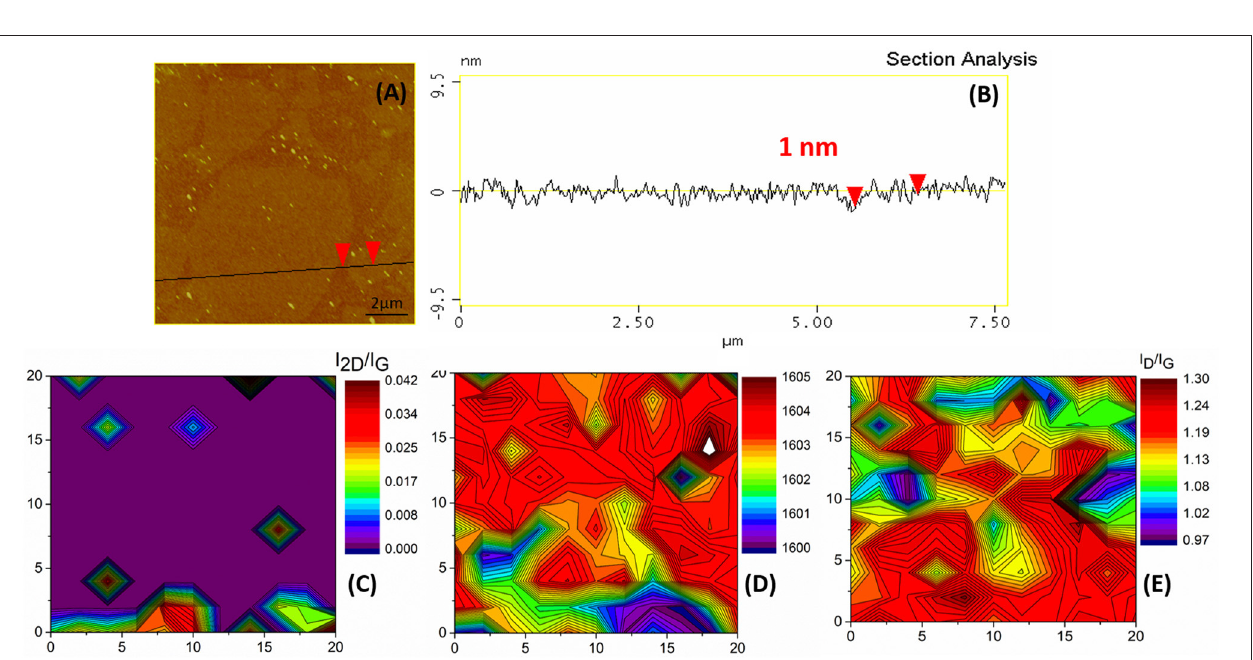
FIGURE 9 | a2-G flakes onto the Si substrate. (A) A high magnification AFM image. The black line and the red arrows indicate the section and point of measurement, respectively for (B) , which is a section analysis with an indicative height measurement. (C) Raman 2D contour plot of the I 2D /I G . (D) Raman 2D contour plot of the G position. (E) Raman 2D contour plot of the I D /I G ratio. Axis dimensions in all Raman plots are in µ m.